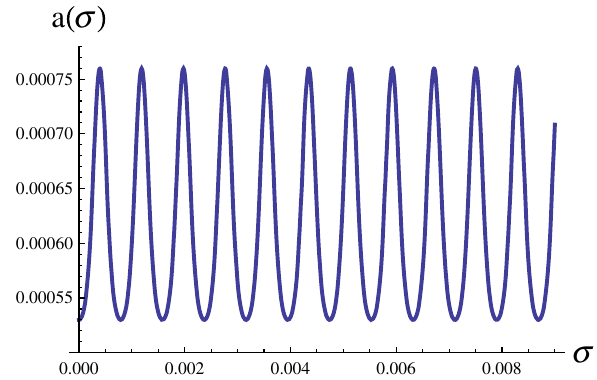
Fig. 15 Illustration of the evolution of a (σ) for closed orbit which is contained by the homoclinic orbit, where σ = b tion of time. We choose s × Mpc/(100 × km) as a unit of σ